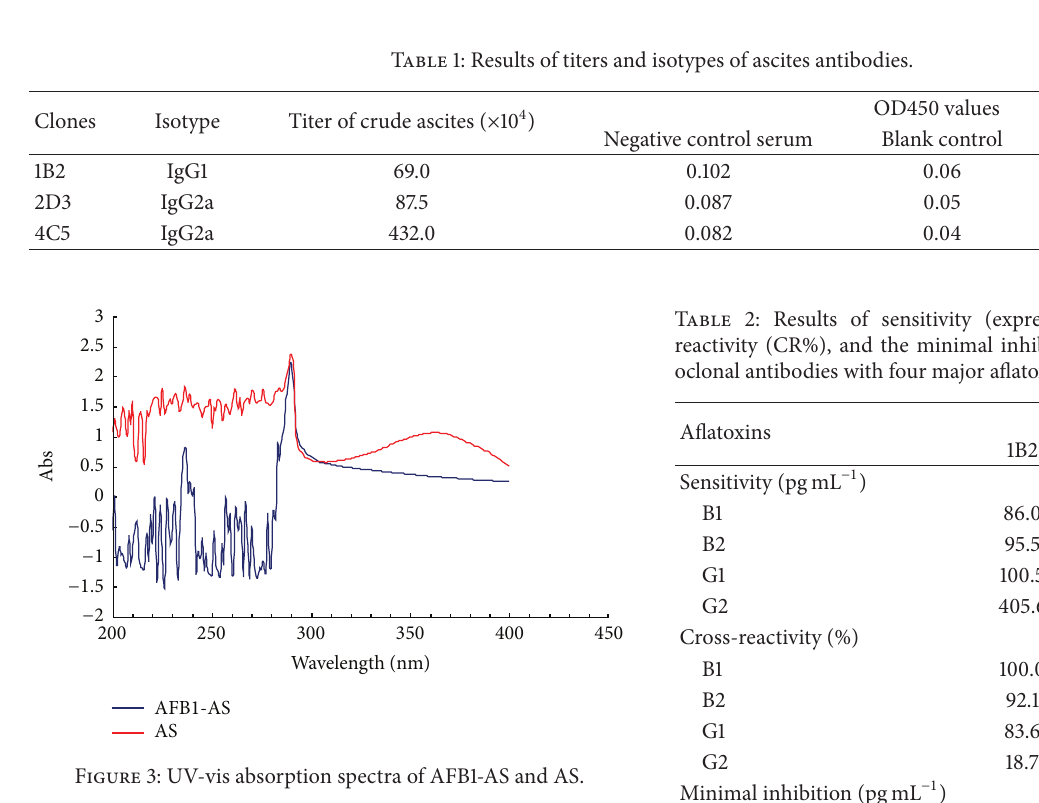
Figure 3: UV-vis absorption spectra of AFB1-AS and AS.